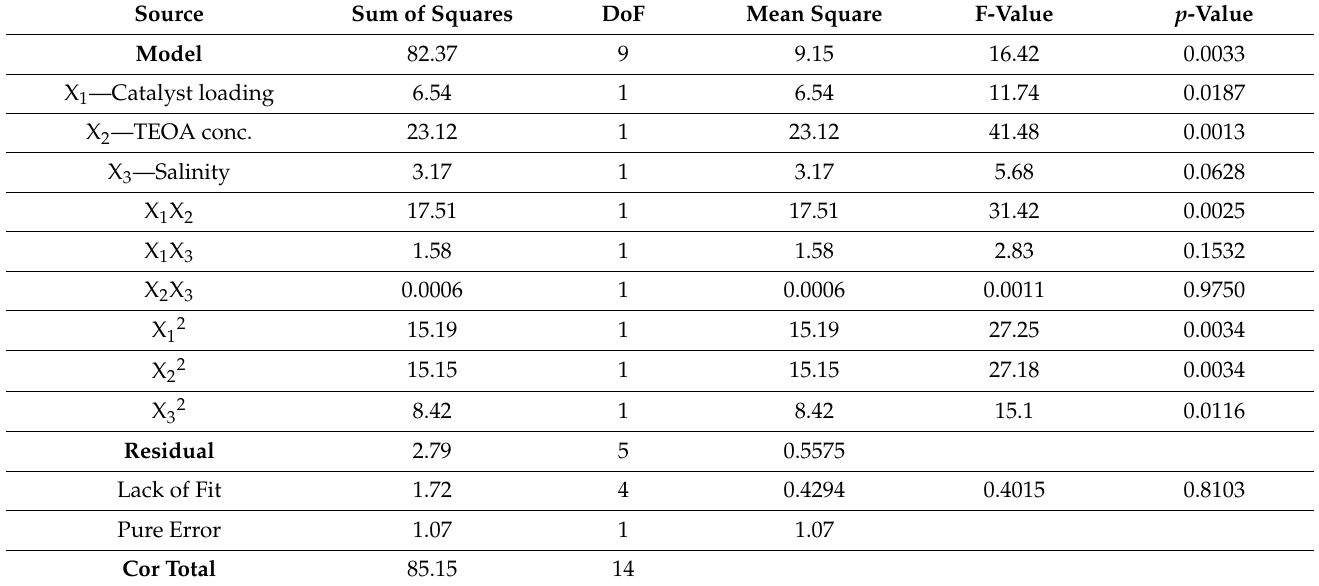
rate via Box–Behnken